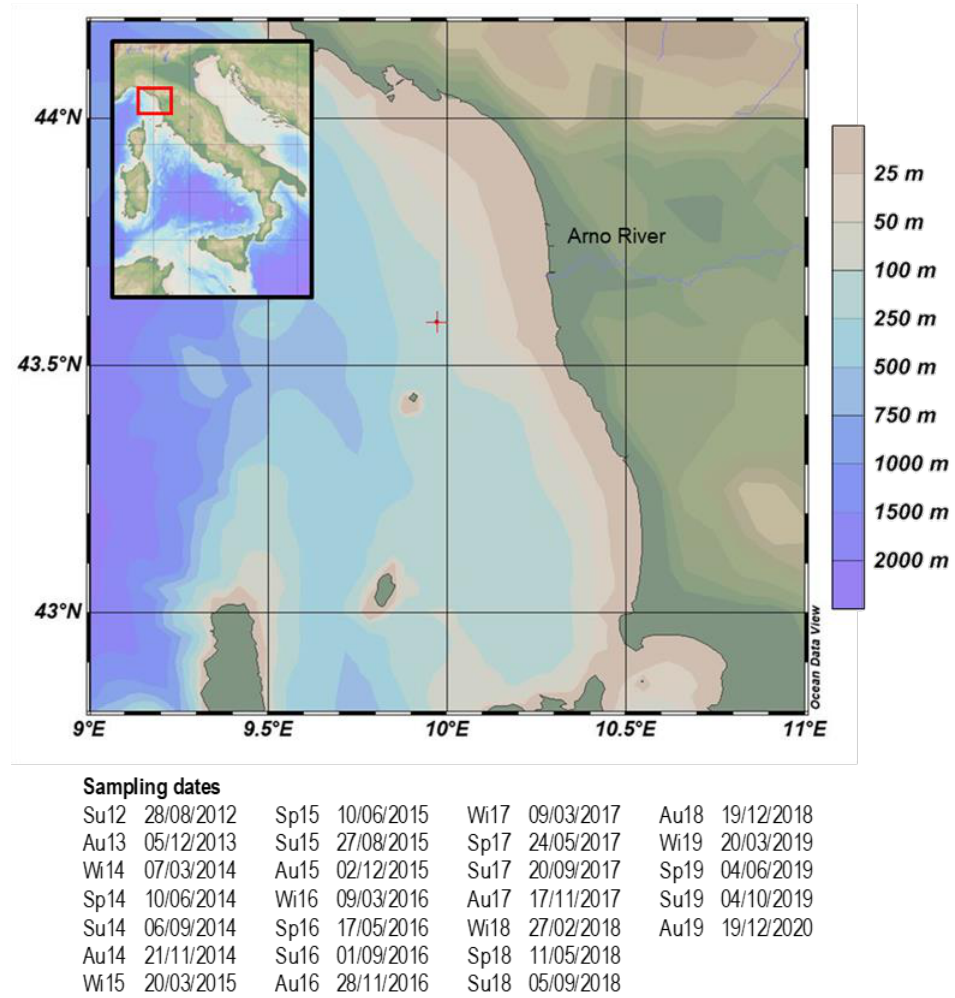
Figure 1. Location of the sampling site in the southeastern Ligurian Sea and sampling dates list.